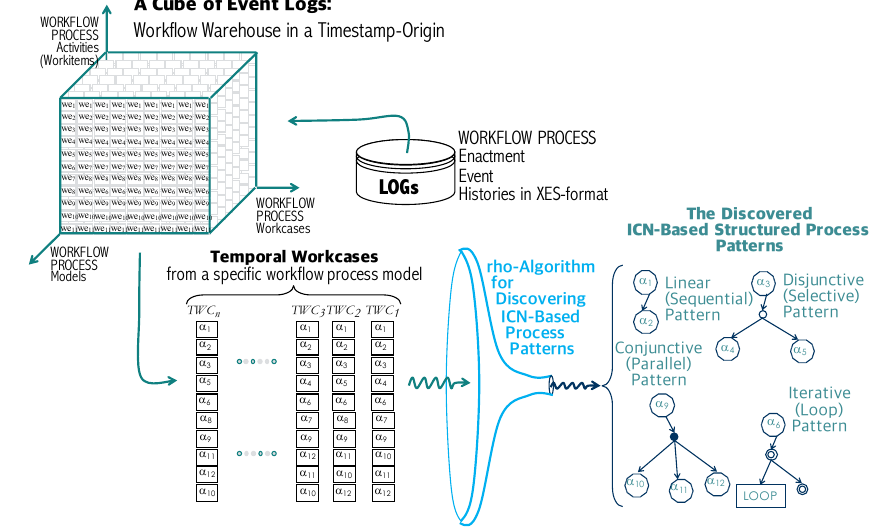
Figure 4. The process mining